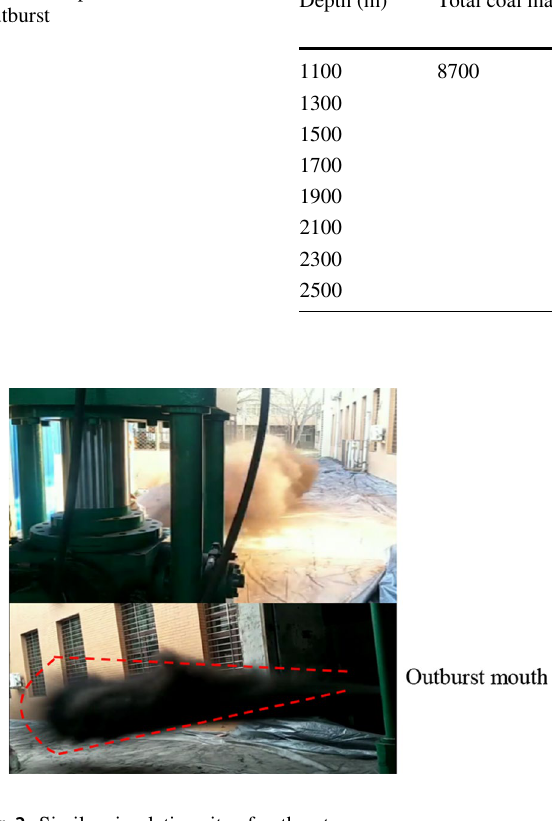
Table 4 Experimental results of outburst